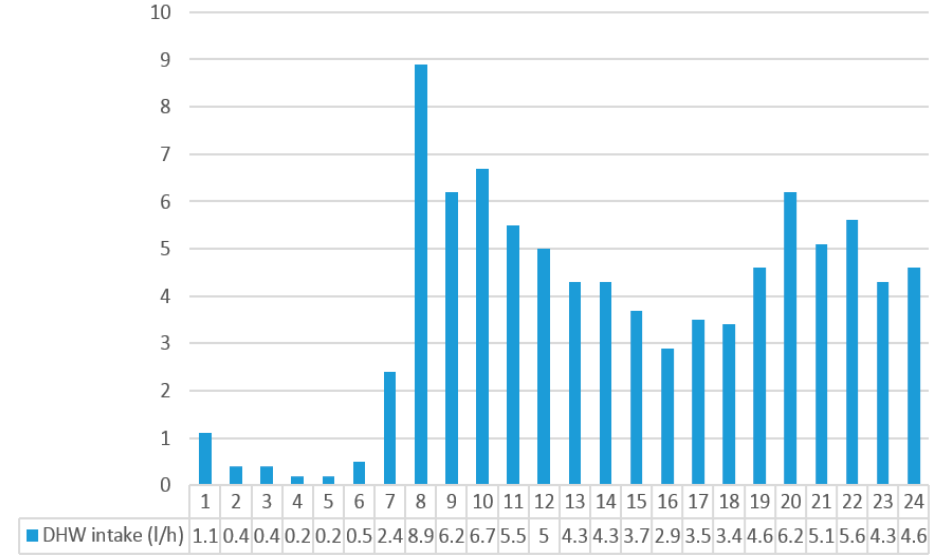
Figure 4. DHW utilization profile.